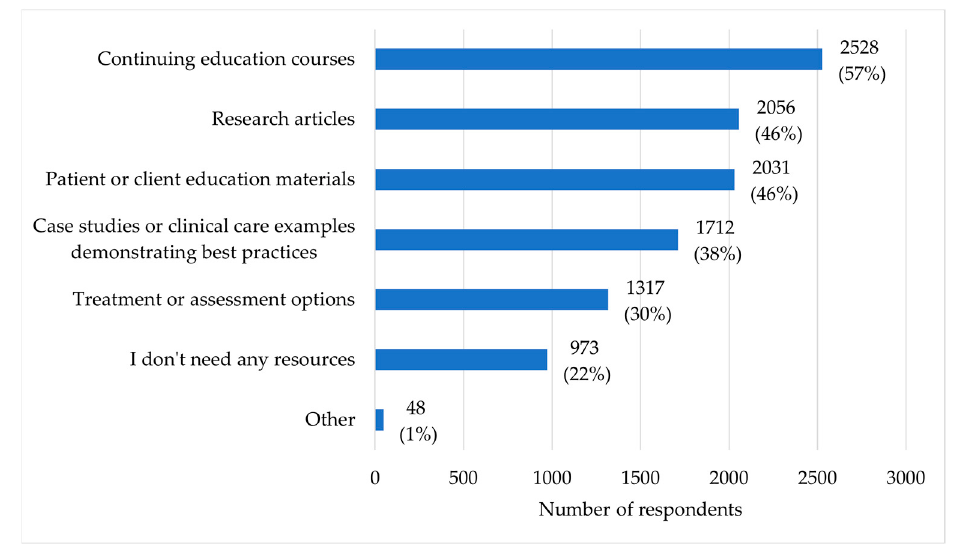
Figure 4. Resources requested by respondents (n = 4196) .